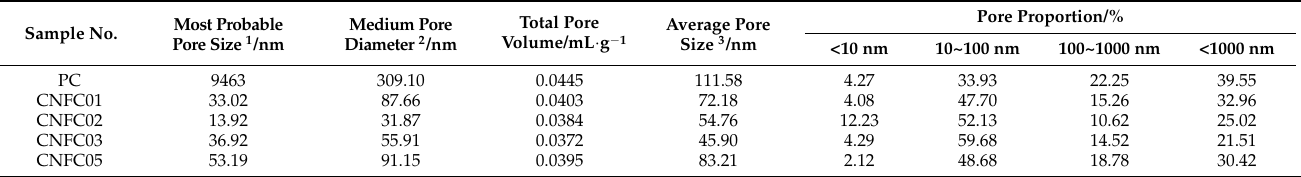
Table 3. Pore characteristic parameters of each group of samples.